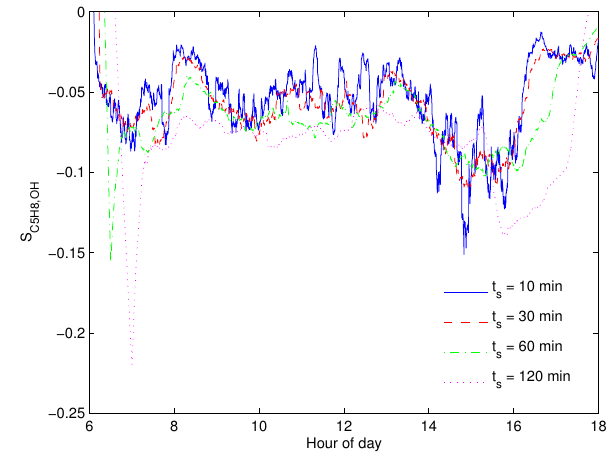
Fig. 3. Variation in S C due to using t s =10, 30, 60 and 5 H 8 , OH 120min. Carried out using OP3 isoprene measurements collected on